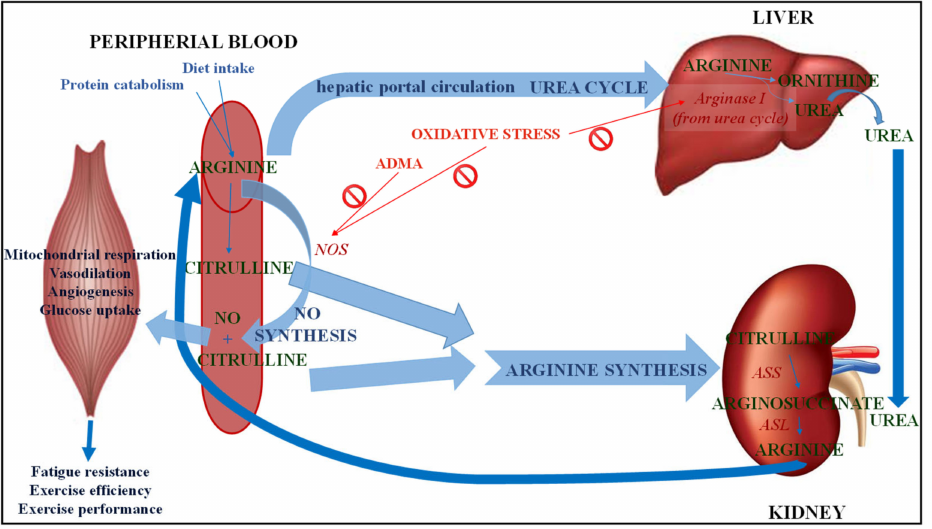
Figure 2. Metabolism of citrulline. NO: Nitric oxide; NOS: Nitric oxide synthase; ADMA: Asymmetric dimethyl arginine; ASS: Argininosuccinate synthase; ASL: Argininosuccinate